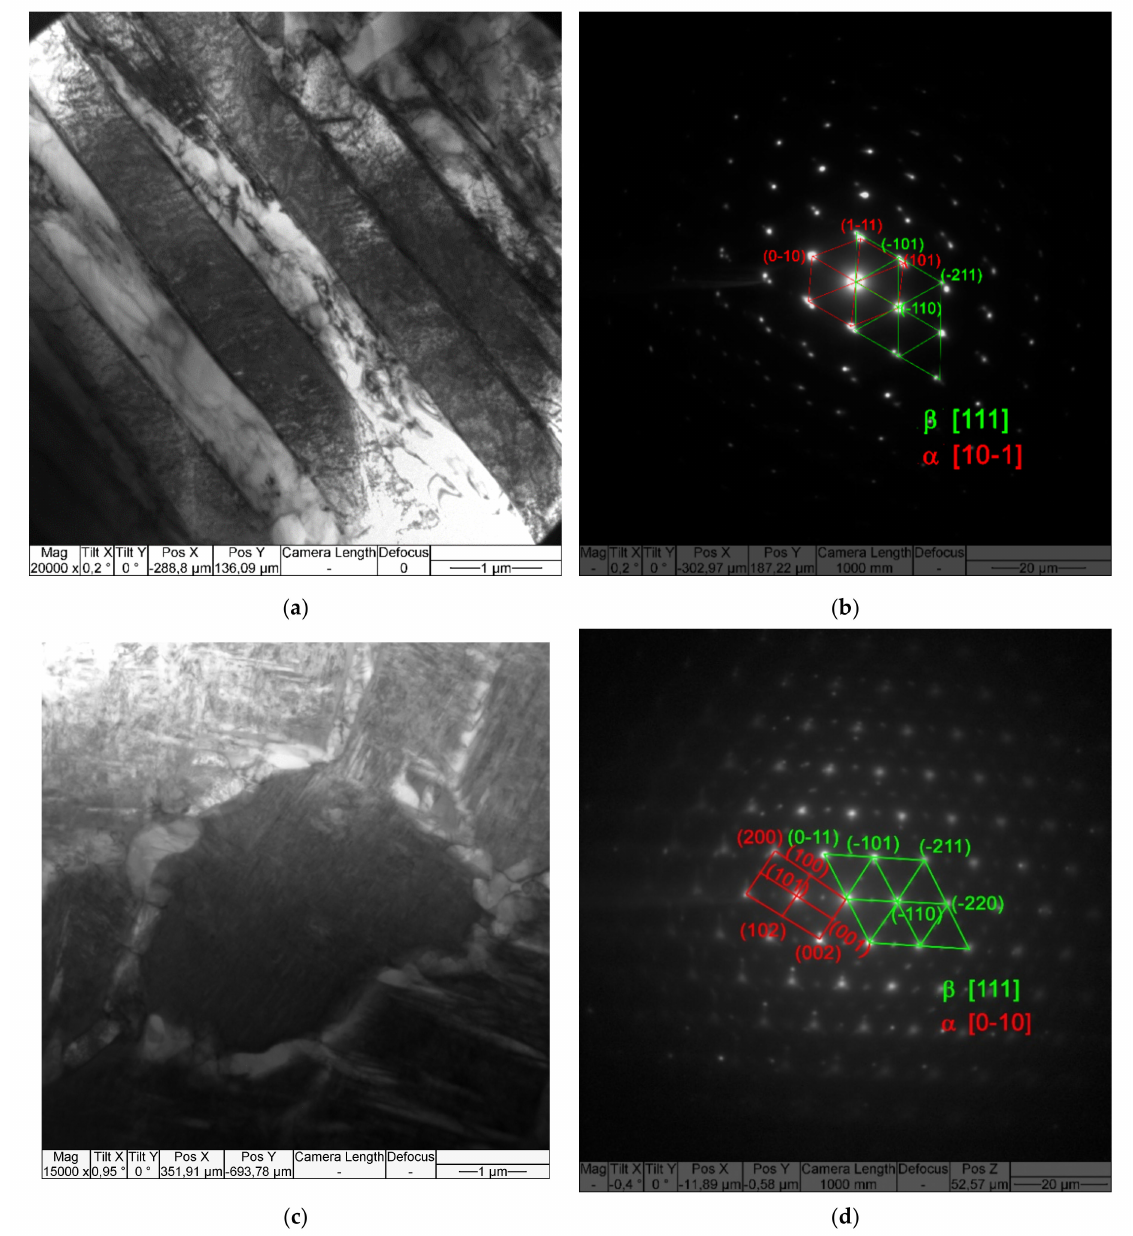
Figure 6. Light-field TEM images and microdiffraction patterns: ( a , b ) additive Ti-6Al-4V; ( c , d ) additive Ti-6Al-4V after